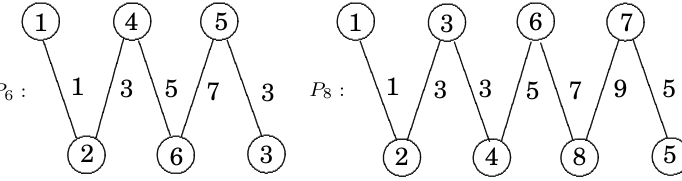
Figure 3: Rainbow mean colorings of P